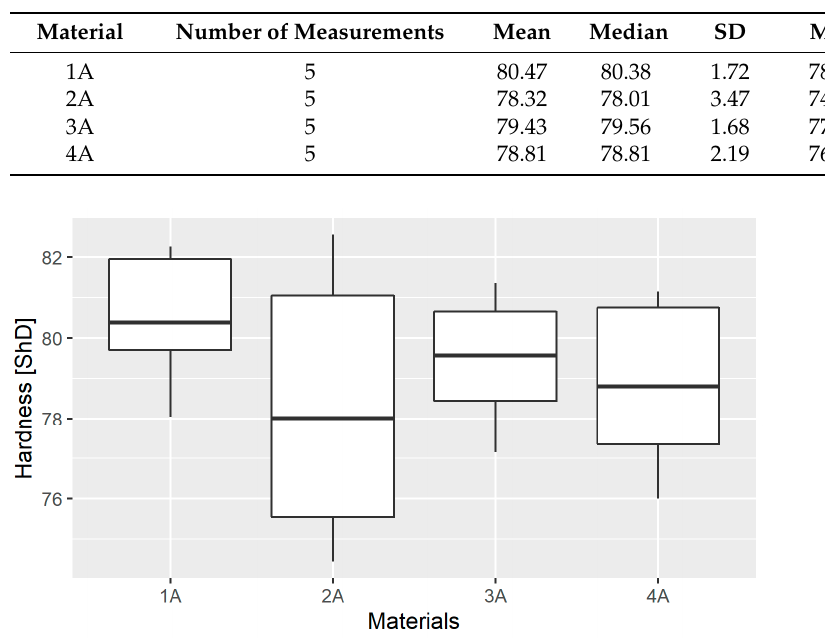
Figure 7. Box plot of hardness in different material groups.